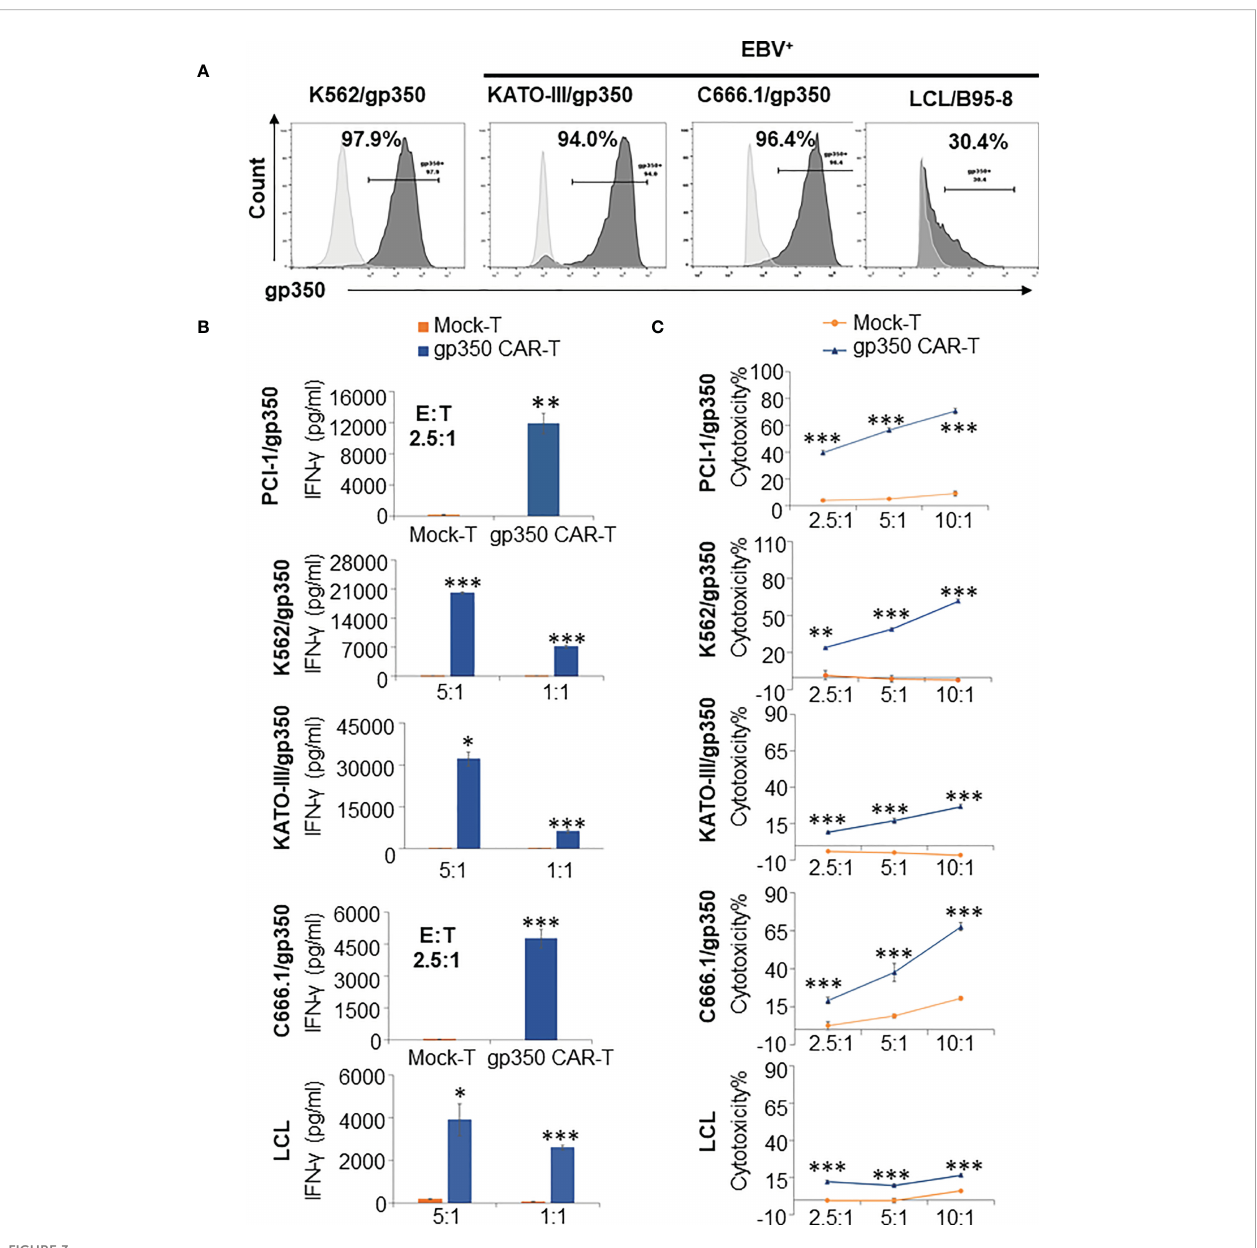
FIGURE 3 Potency testing of gp350CAR-T cells produced after scale-up against different cell targets expressing gp350. (A) Flow cytometry analyses of gp350 expression on various cancer cell lines: EBV - PCI-1 expressing gp350 (PCI-1/gp350), EBV - myeloid leukemia line K562 expressing gp350 (K562/gp350), EBV - gastric carcinoma KATO-III expressing gp350 (KATO-III/gp350), EBV + nasopharyngeal carcinoma C666.1 expressing gp350 (C666.1/gp350), and an EBV + B95-8-derived lymphoblastoid cell line (LCL). (B) Analyses of secreted IFN- g . Gp350CAR-T cells were co cultured with above tumor cell lines for 16 h at indicated E:T ratios and IFN- g release level was quanti fi ed by ELISA. t test, compared to mock-T, *P ≤ 0.05, **P ≤ 0.01, ***P ≤ 0.001. (C) In vitro cytotoxicity assays. gp350CAR-T were co-cultured with PCI-1/gp350, KATO-III/gp350, C666.1/gp350 and LCLs and LDH-based cytotoxicity assay (performed after 16 h of co-culture) or Del fi a EuTDA cytotoxicity assay (performed after 2 h of co-culture) were performed. Mock-T cells were included as controls. The results are presented as means ± s.d. t test, compared to mock-T, *P ≤ 0.05, **P ≤ 0.01, ***P ≤ 0.001. Independent triplicate experiments were performed with gp350CAR-T cells produced with one PBMC